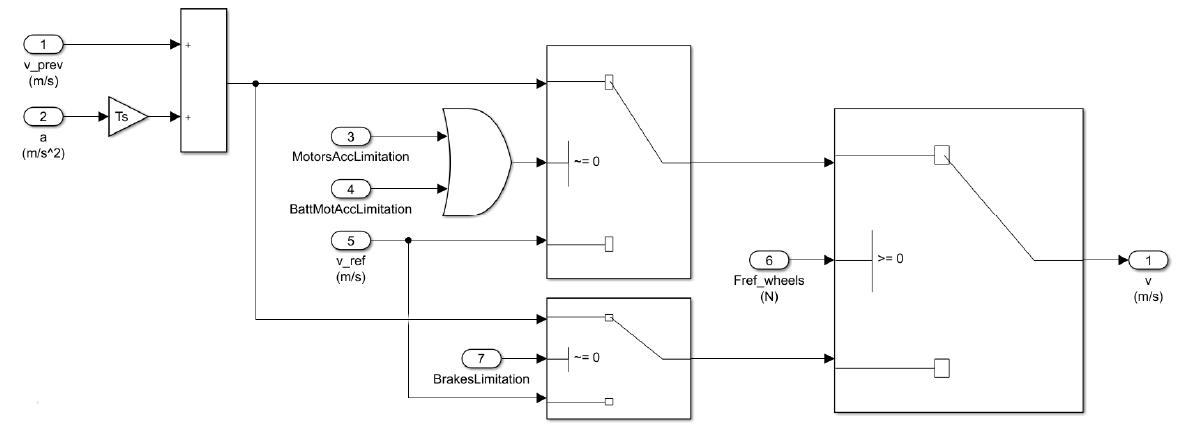
Figure 3. Simulink logical scheme adopted to obtain the instantaneous vehicle speed.